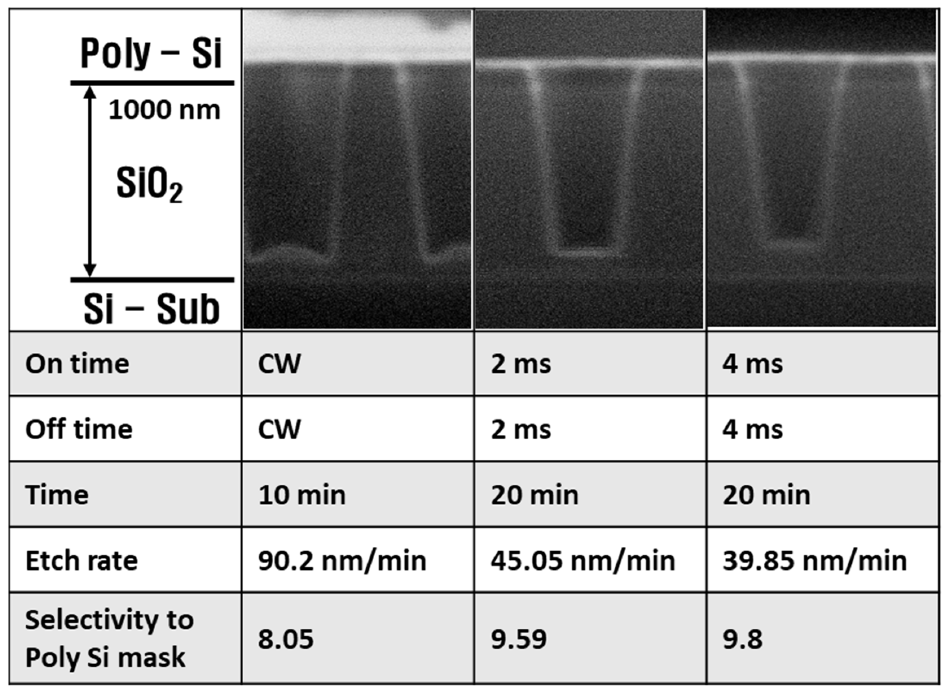
Figure 5. SiO 2 etching profile, etch rate, and selectivity of SiO 2 /Si at increasing on/off times.